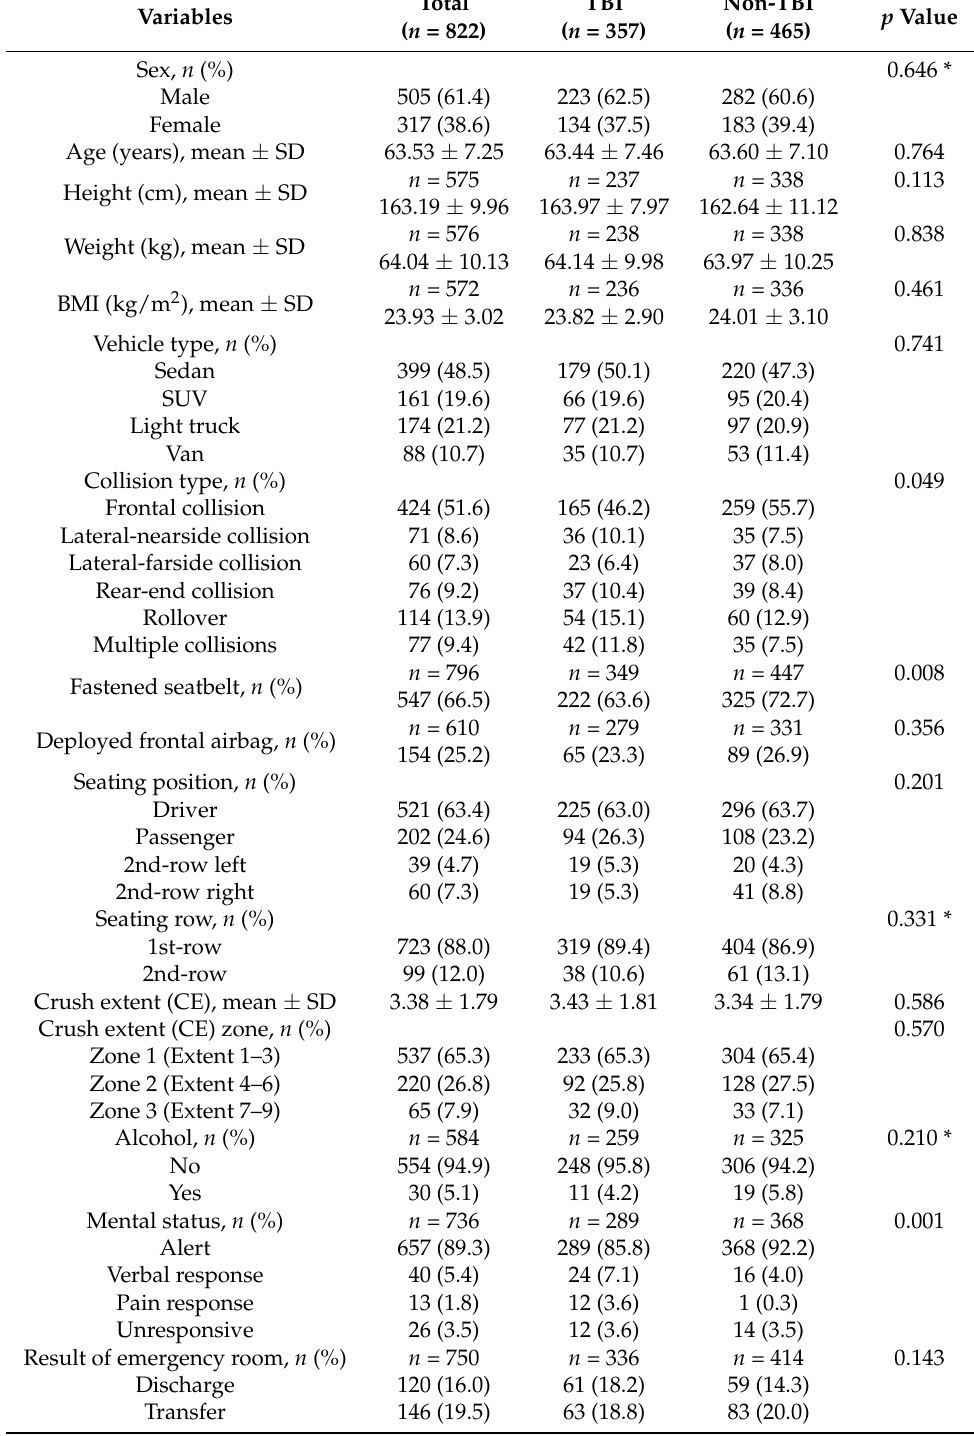
Table 1. General characteristics of elderly motor vehicle occupants